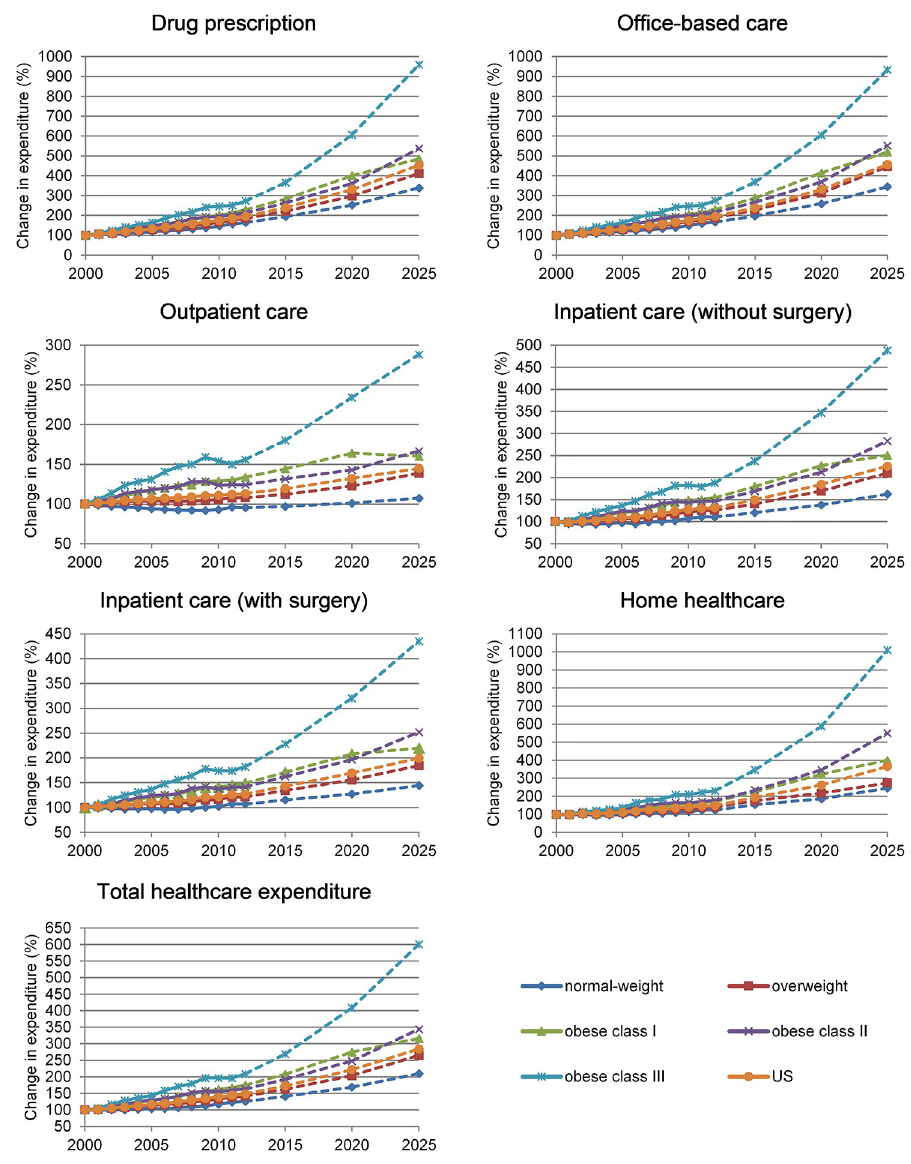
Fig 2. Change in healthcare expenditure (%) by category of service and BMI; US population 2000–2025. Note: continuous lines represent historical trends; dotted lines represent projections; BMI (Body Mass Index) categories are defined according to WHO thresholds (WHO 2016) for adults and Cole et al. 2000 for children and teenagers; 2000 is base year equal to 100; additional results in the S2